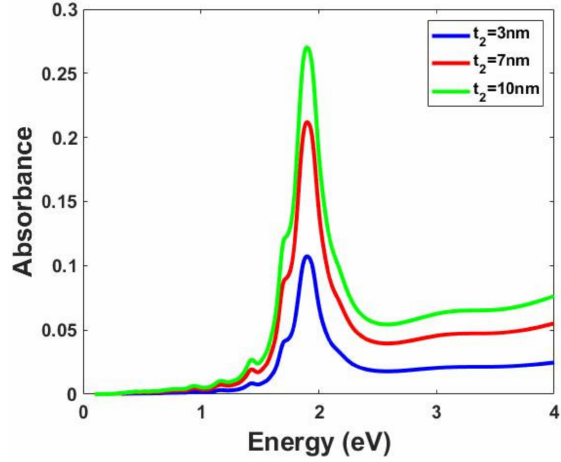
Figure 7. LSPRs formation for Au NPs when t 2 = 3 nm, 7 nm, 10 nm.